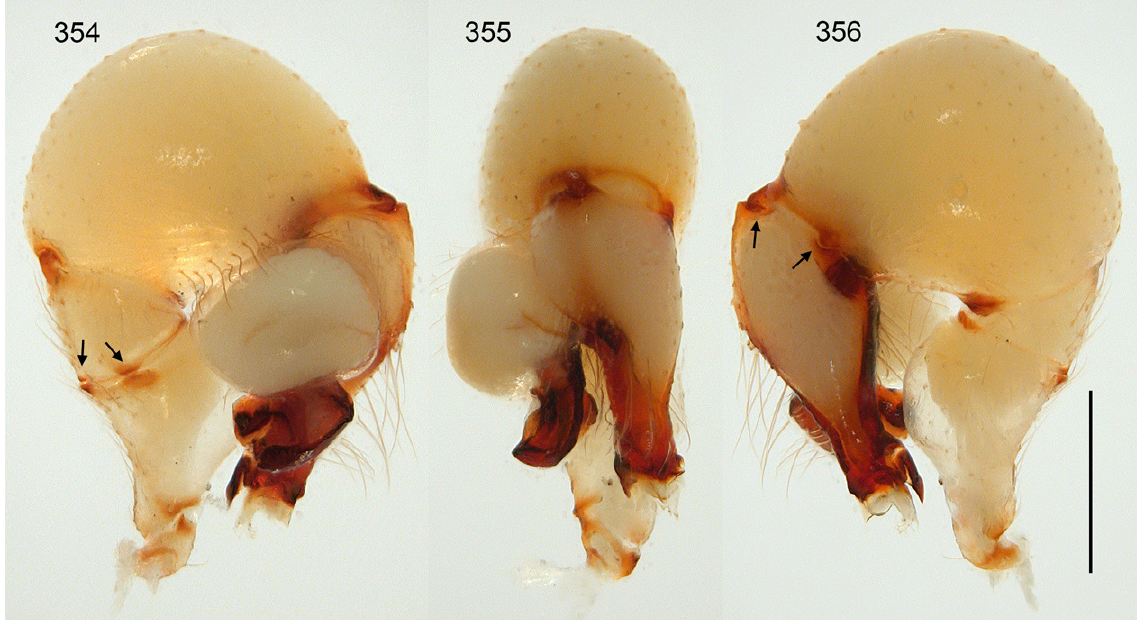
Figs 354–356. Crossopriza soudanensis Millot, 1941; lectotype male from Burkina Faso, Ouagadougou (MNHN Ar 10520); mirror images of right palp, prolateral, dorsal, and retrolateral views; arrows: joints between femur and patella and between tibia and tarsus. Scale bar = 0.5